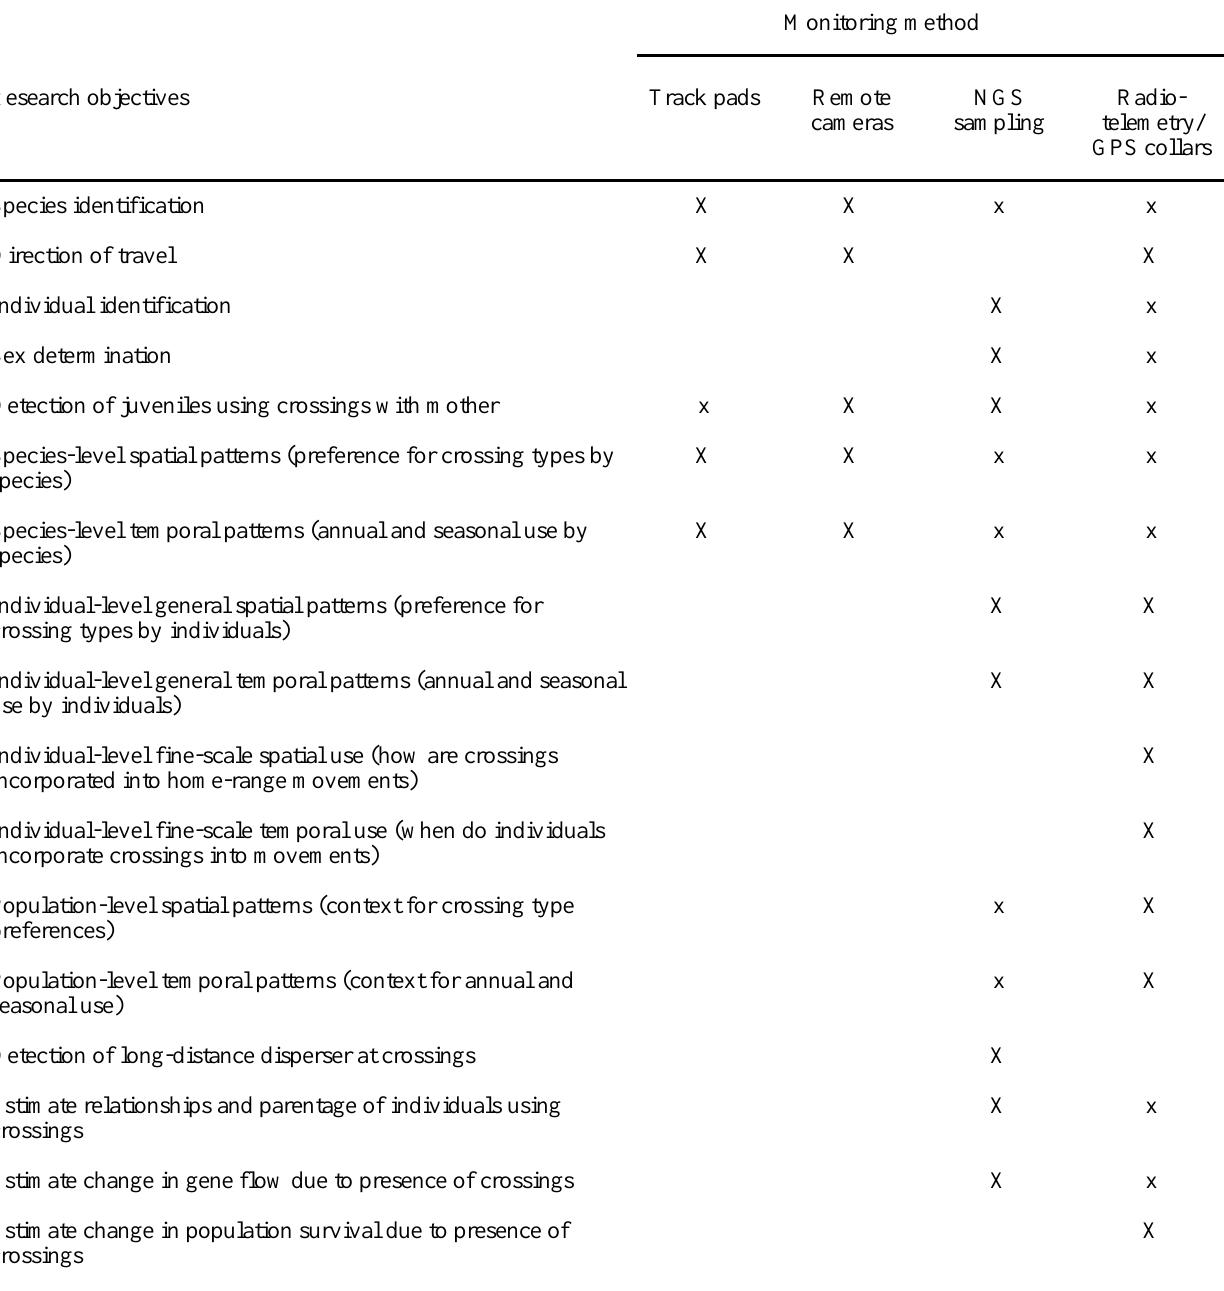
Table 1. Comparative applicability of non-invasive genetic sampling (NGS) with other monitoring methods for addressing specific research objectives related to animal movement at wildlife crossing structures and population connectivity across roads. GPS = global positioning system. X = best method, x = suitable